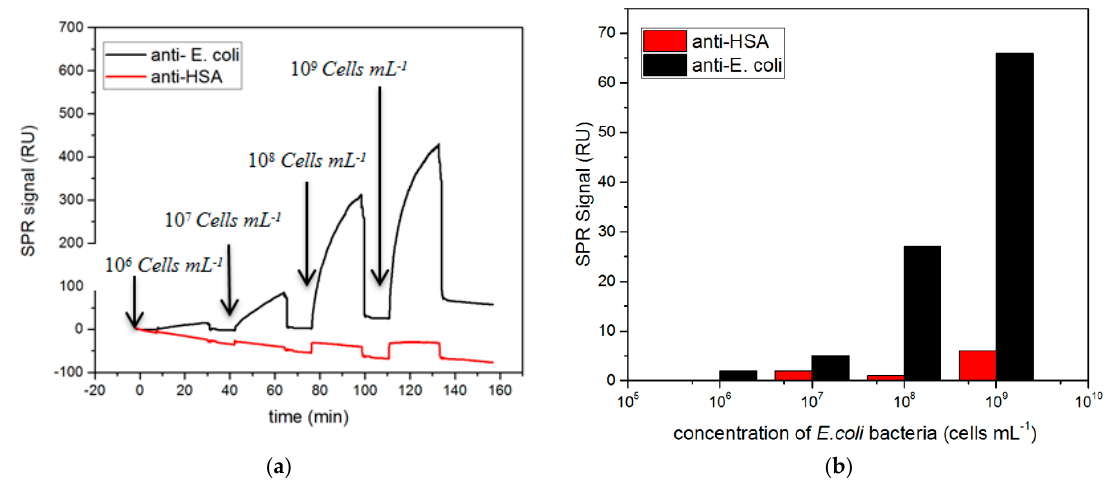
Figure 3. SPR evaluation of E. coli specific binding to anti- E. coli in comparison to anti-HSA (negative control). ( a ) SPR kinetic curves obtained during injections of E. coli from 10 6 to 10 9 cells mL − 1 . ( b ) SPR responses as a function of the concentration of bacteria (after washing in PBS. The SPR signal was obtained by subtracting the reference channel signal (without antibodies)).